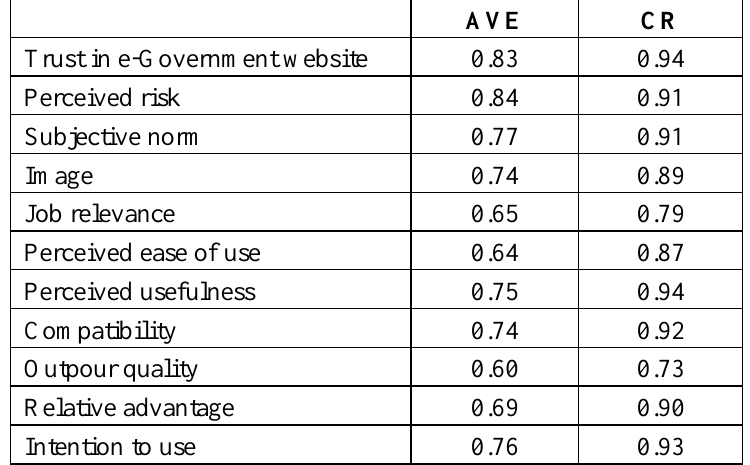
Table 2. Composite Reliability (CR), and Average Variance Extracted